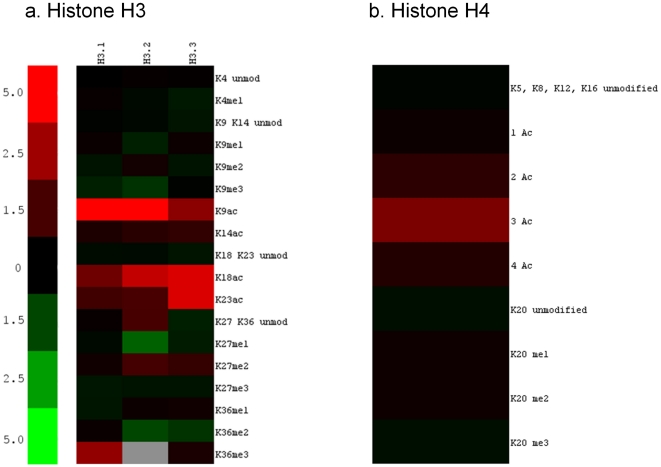
Heat map depicting the ratio of histone H3 and H4 PTMs abundances in euchromatin relative to heterochromatin.Heat maps for histone variants H3.1, H3.2 and H3.3 (a.) and histone H4 (b.). The scale indicates the fold change between a given PTM abundance in euchromatin versus heterochromatin. Red indicates an enrichment of a given PTM in euchromatic regions while green corresponds to enrichment in heterochromatin.